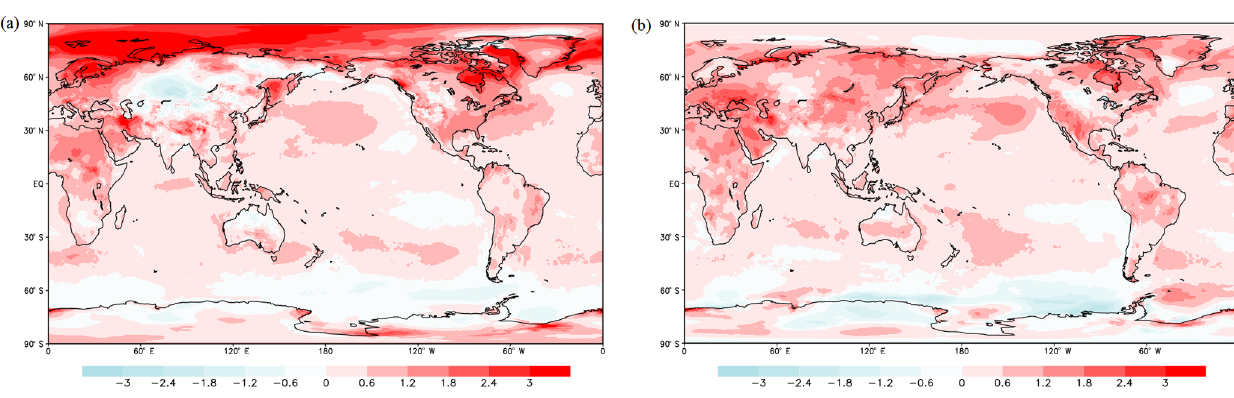
Figure 1. Polar amplification using long-term observations of surface air temperatures ( ◦ C) for 2008–2018 (seasonal average) relative to